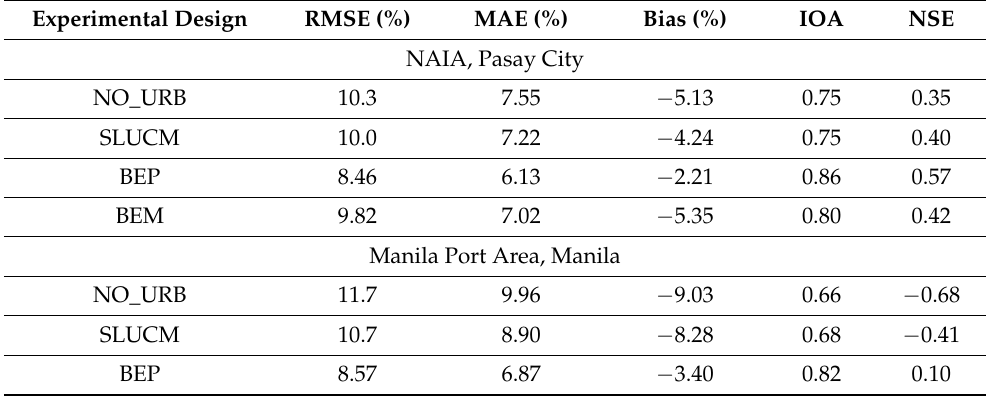
Table 6. As in Table 4 but for relative